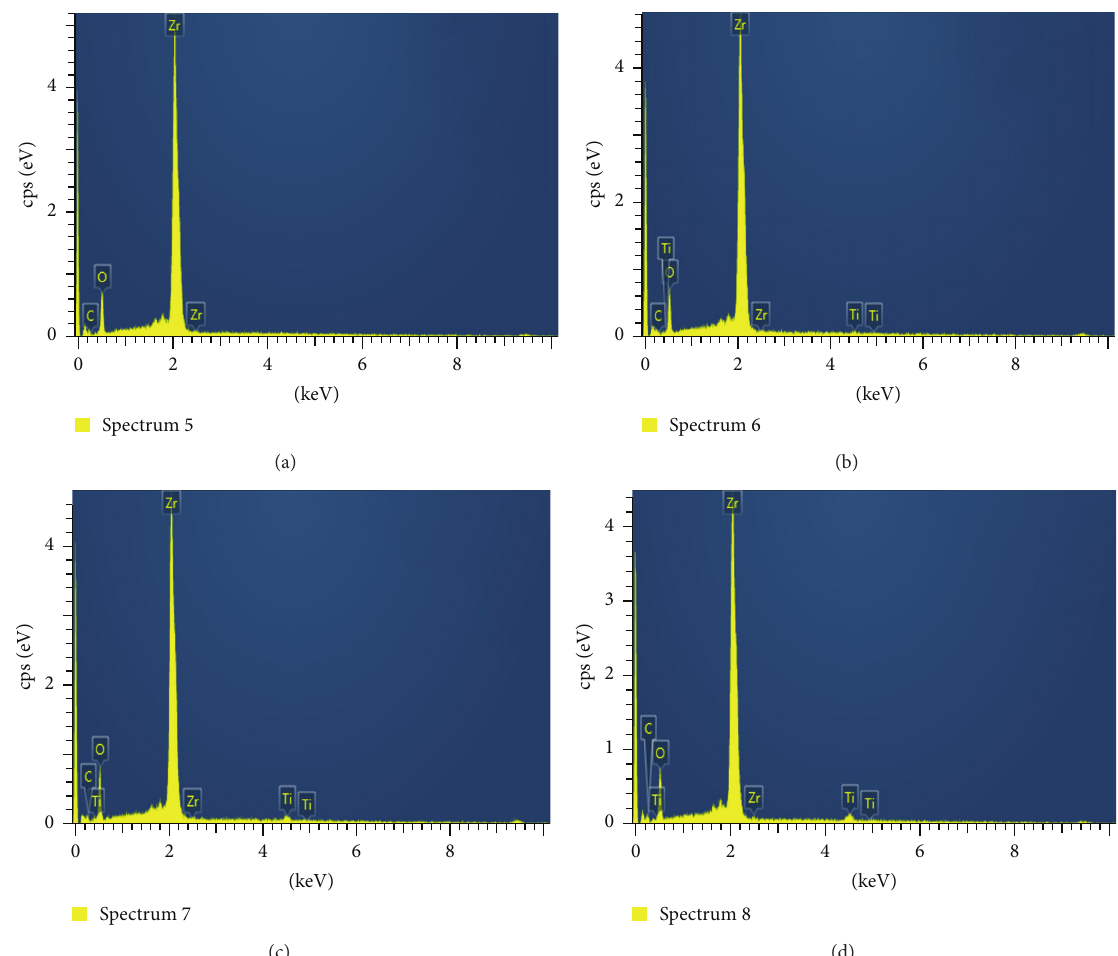
Figure 3: EDS analysis of the microwave sintered ZrO 2 ceramics with addition of (a) 0, (b) 1, (c) 3, and (d) 5 wt% TiO 2 contents.